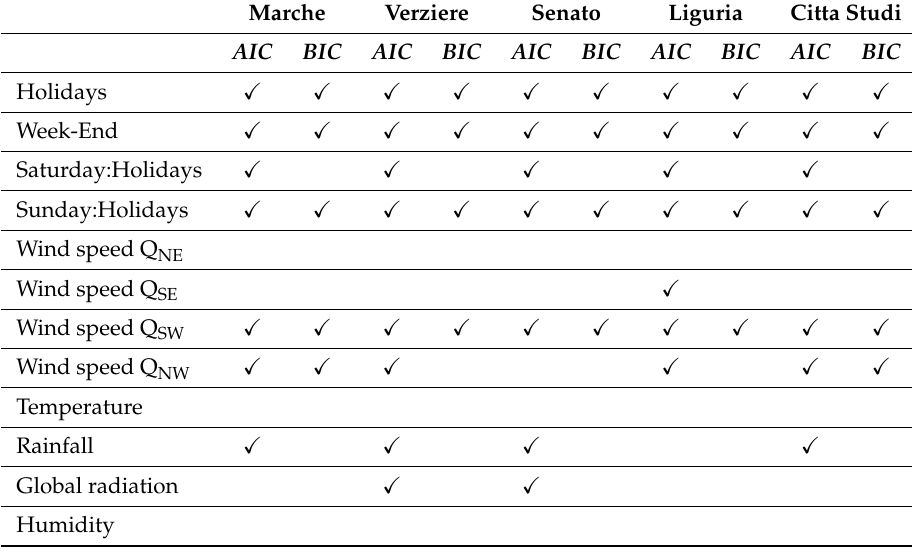
Table 2. Model selection-Step 3-NO x : Best subset of covariates using backward-forward stepwise algorithms for NO x .